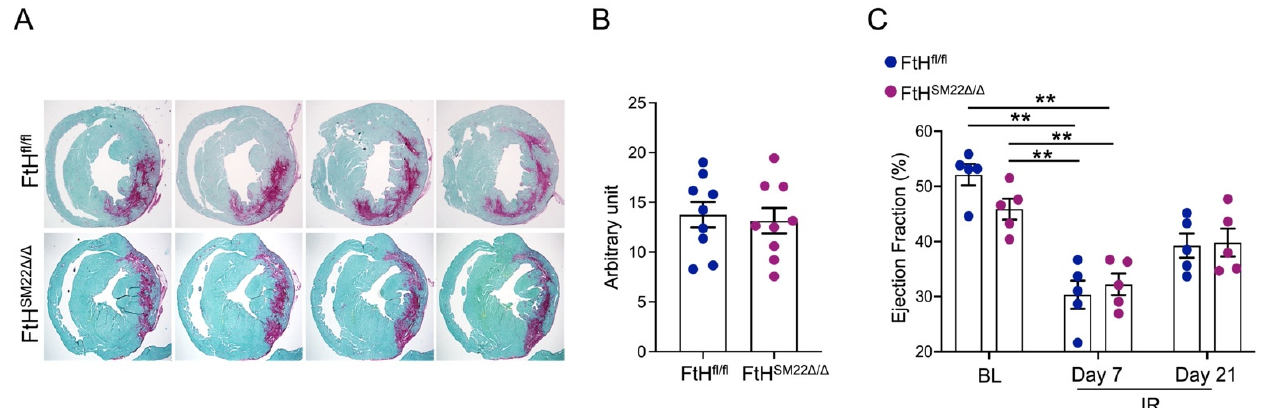
Figure 5. FtH deletion does not impact myocardial fibrosis or left ventricular ejection fraction. ( A ) Representative images of series of transverse sections at 7 days post IR in FtH fl/fl and FtH SM22 Δ / Δ mice. Sirius red/fast green collagen staining marks myocardium (green) and scar (red). Magnification 4×. ( B ) Quantification of collagen deposition by measuring intensity of sirius red stain encompassing positive staining areas above threshold at seven days post IR. Data are presented as means ± SEM. ( C ) Demonstration of left ventricular ejection fraction % under BL conditions, and on days 7 and 21 post IR. Data are presented as means ± SEM. n = 5/genotype. ** p < 0.01.